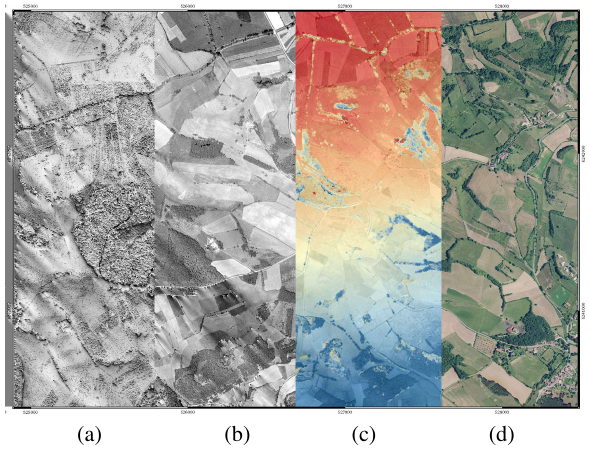
Figure 4. Results for Fabas 1984 (3.5 km × 3 km). (a) Coarse absolute DSM; (b) Coarse absolute orthoimage; (c) Altimetric residuals between coarse DSM and reference DSM (+ 60m → + 20m ); (d) Reference orthoimage.